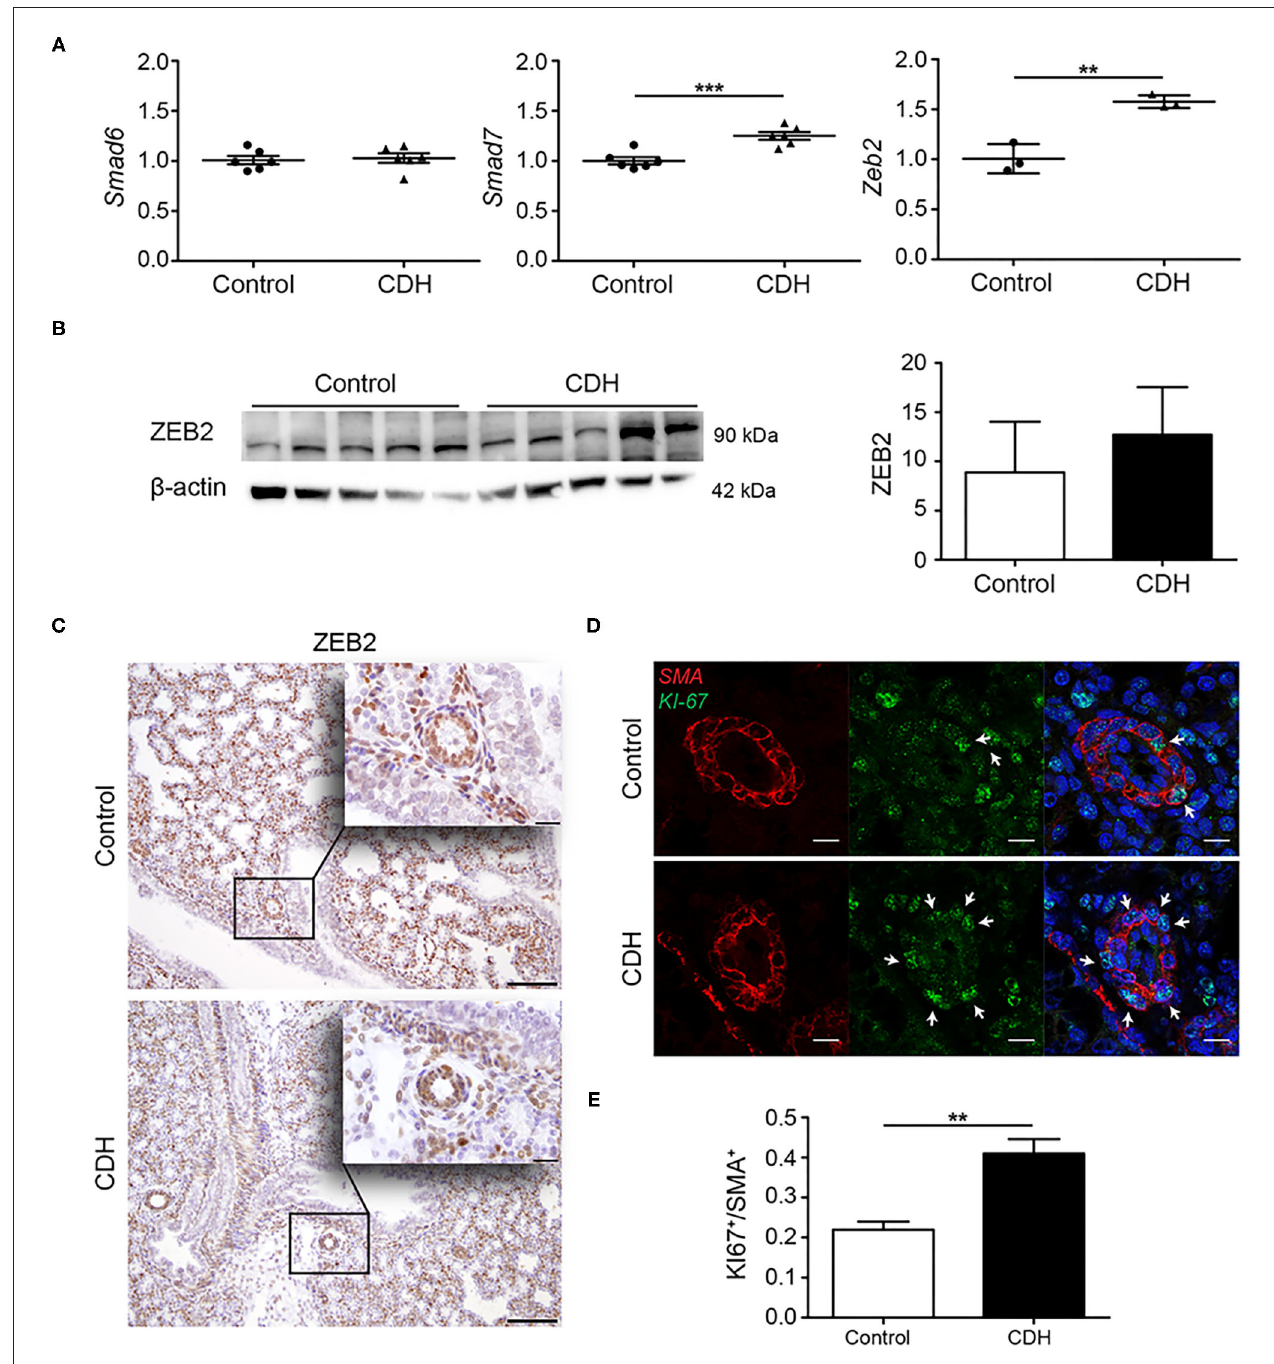
FIGURE 4 | Modulators of TGF β signaling are upregulated in CDH. (A) Quantitative PCR revealed no difference in the abundance of the inhibitory Smad6 mRNA transcript, but increased abundance of inhibitory Smad7 and Zeb2 mRNA transcripts [ p < 0.001 and p = 0.003, respectively; n = 3 ( Zeb2 ) or 6 ( Smad6 , Smad7 ) per group; y-axis indicated fold-change]. (B) Western blot analyses of whole lung homogenates revealed no significant differences in ZEB2 protein abundance comparing CDH and control groups, where β -actin was used as a loading control, and as a reference for quantification ( n = 5 for both groups). (C) Representative images of immunohistochemistry staining show no differences in expression of ZEB2 in the small vessels of all lungs ( n = 3 samples for both groups). Scale bars represent 100 µ m (low power) and 20 µ m (high power). ** p < 0.01, *** p < 0.001. Error bars represent SD. (D) Increased proliferation of the muscular vessel wall in CDH. Representative images of immunofluorescence staining revealed an increase in KI-67/SMA double-positive cells in small pulmonary vessels in CDH ( p = 0.001; n = 3 samples for both groups). (E) Quantification of proliferative SMA + cells. Four vessels per sample were counted. Scale bars represent 10 µ m. ** p < 0.01, *** p < 0.001. Error bars represent